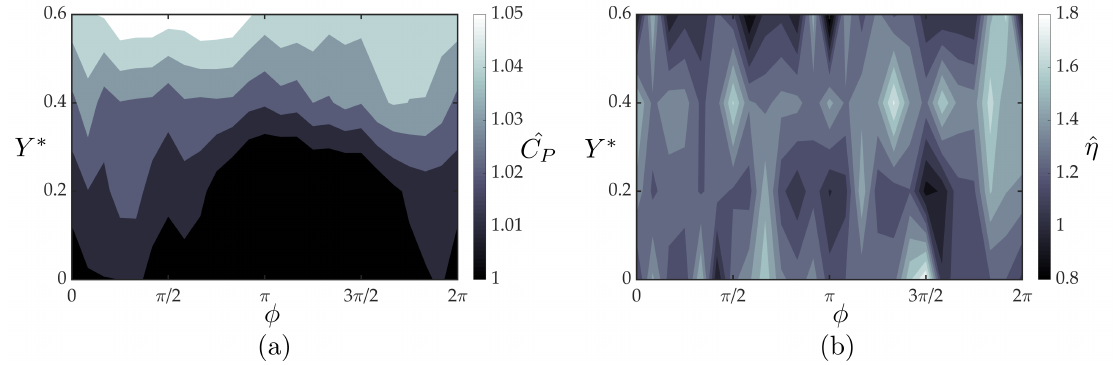
Figure 11. Measured normalized ( a ) power coefficient and ( b ) efficiency for the follower